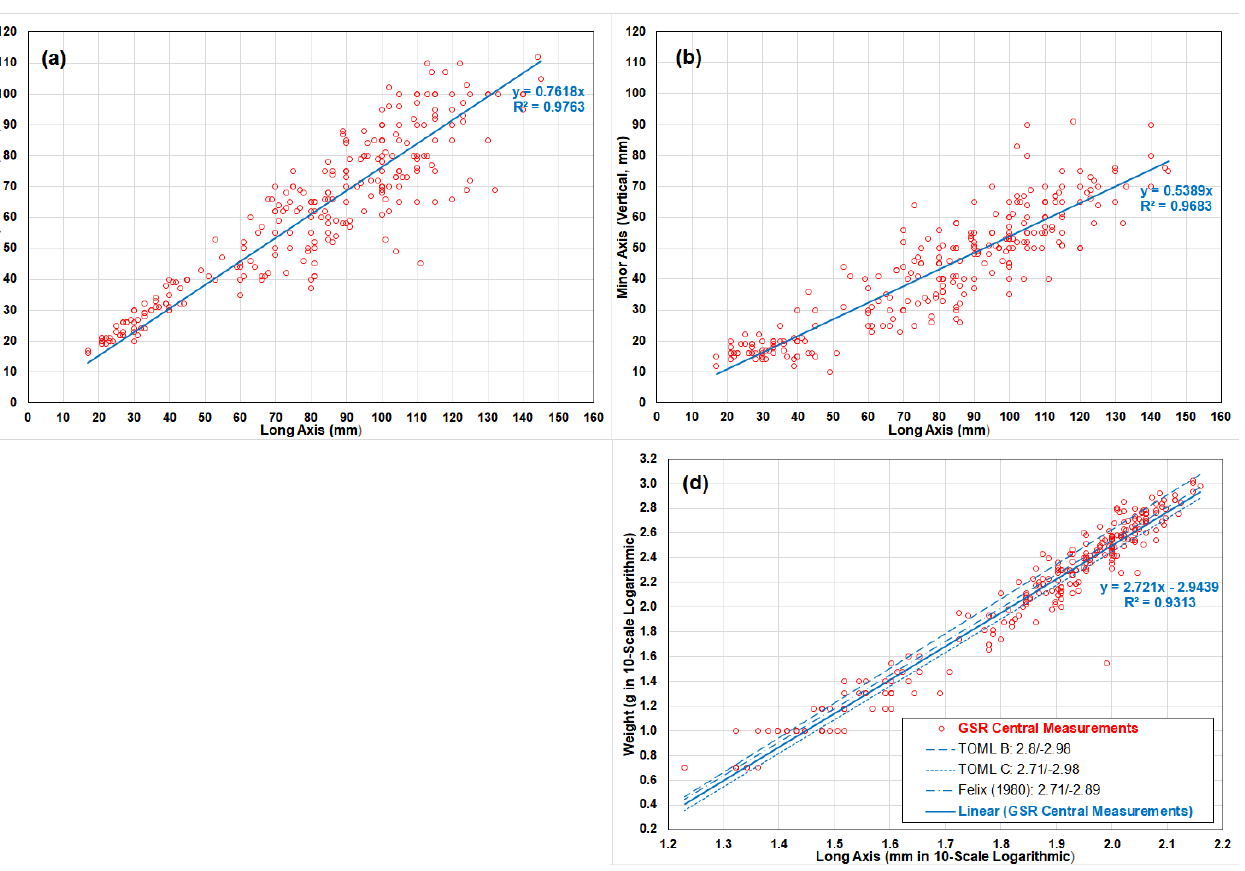
Figure 6. Linear Regression between Nodule Dimensions and Weights for GSR Central Region. Data source [14]. Note in ( d ) the legend shows the slopes and intercepts of the linear regressions of the data of Felix [13] and TOML [4], where the intercepts are converted from cm to mm (in logarithmic scale). Table 1. Results of Linear Regression for Nodule Dimensions and Weights.